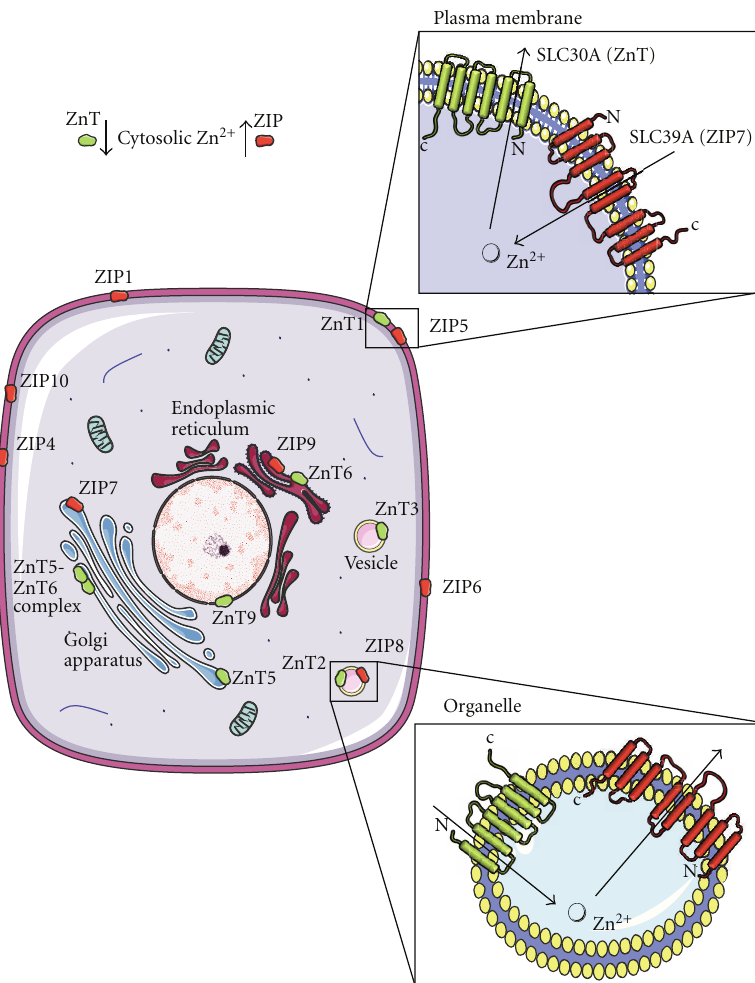
Figure 1: Subcellular localization and direction of transport of the zinc transporter families, ZnT and ZIP . Arrows show the direction of zinc mobilization for the ZnT (green) and ZIP (red) proteins. A net gain in cytosolic zinc is achieved by the transportation of zinc from the extracellular region and organelles such as the endoplasmic reticulum (ER) and Golgi apparatus by the ZIP transporters. Cytosolic zinc is mobilized into early secretory compartments such as the ER and Golgi apparatus by the ZnT transporters. Figures were produced using Servier Medical Art,